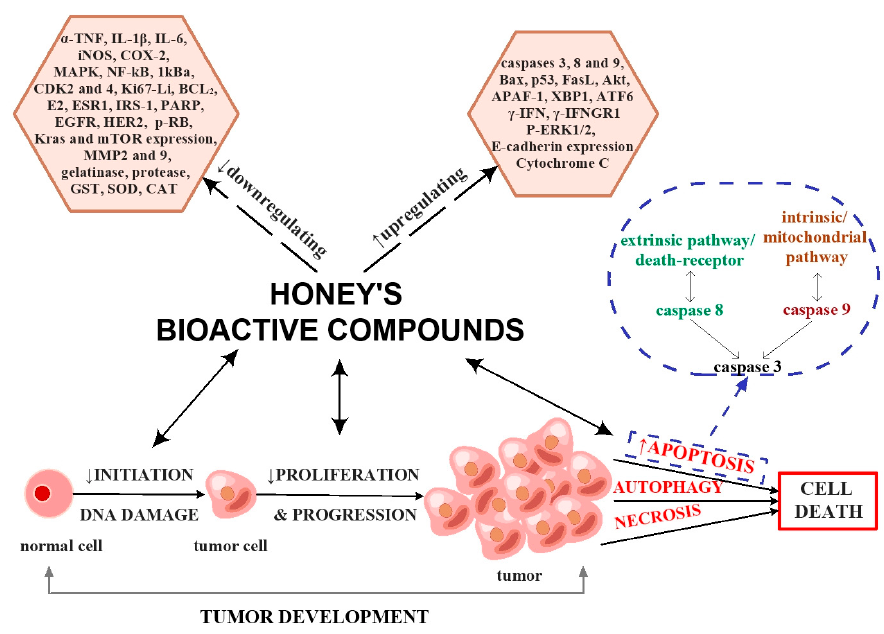
Figure 5. Antitumor effects of honey’s bioactive compounds. The figure was designed with Con- ceptDraw Diagram 16. Draw Diagram